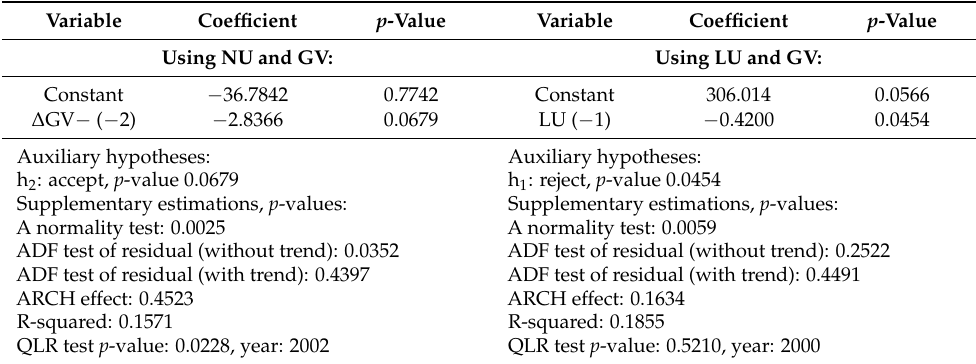
Table A4. NARDL estimations for Estonia after eliminating insignificant